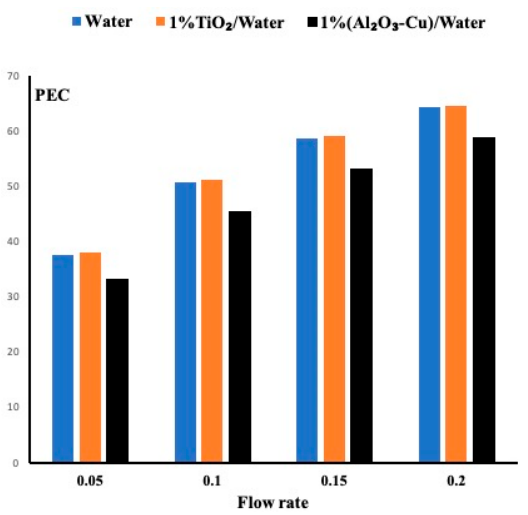
Figure 8. PEC for all cases when the permeability is set at 20 PPI.